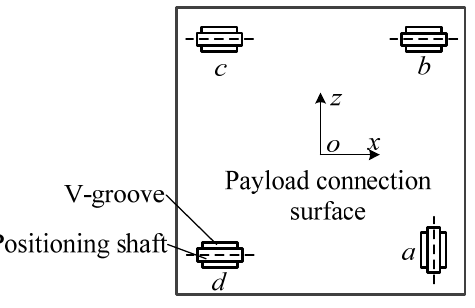
Figure 6. Schematic diagram of the positioning shaft and V-groove layout.